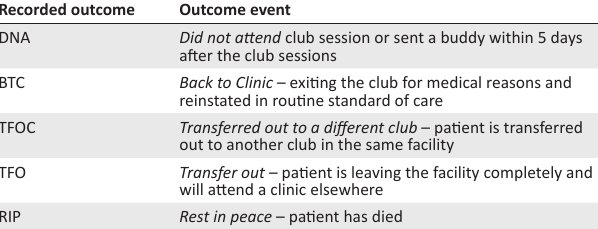
TABLE 2: Modalities defining adherence club attendance. Recorded outcome Outcome event DNA